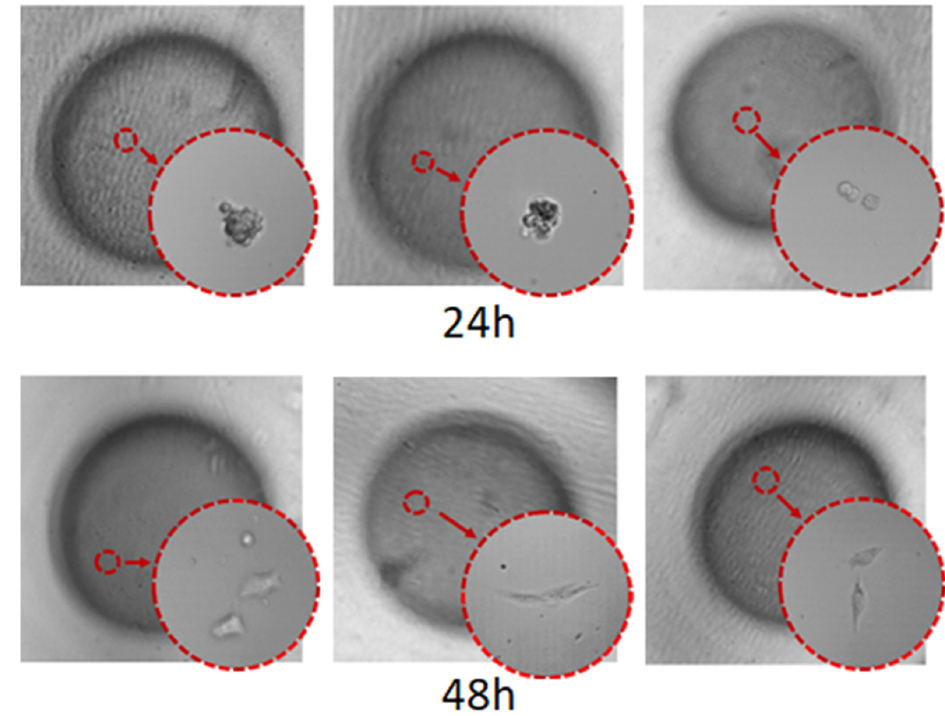
Figure 15. Cell culture in the droplet.